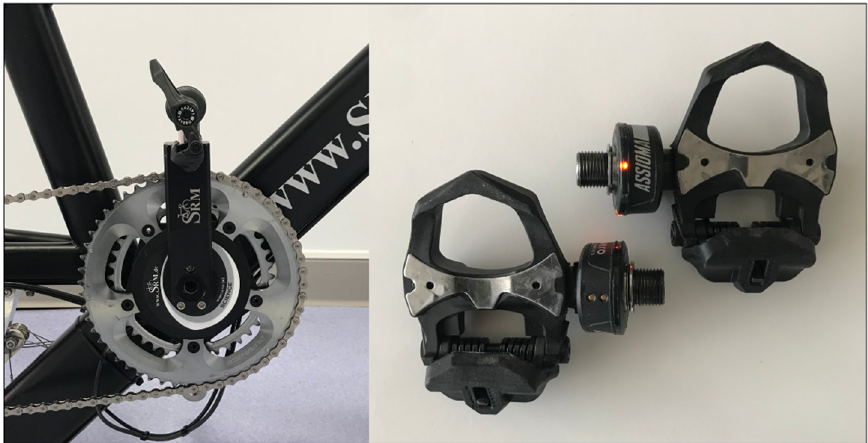
Figure 1. Representative example of the setting used on this study, placing the Favero Assioma Duo pedal power meter on an SRM crank.